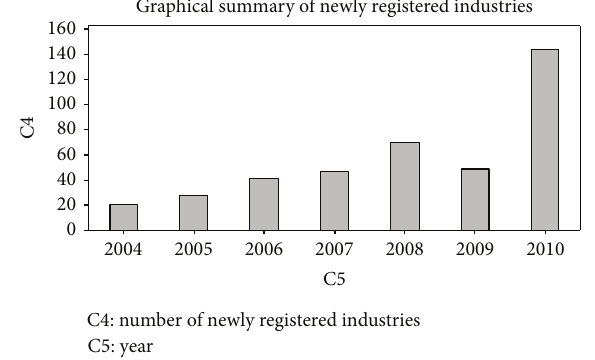
Figure 3: Bar chart of the number of newly registered industries. Table 2: Carbon monoxide concentration (ppm). Source of data: Lagos State Environmental Protection Agency (LASEPA).